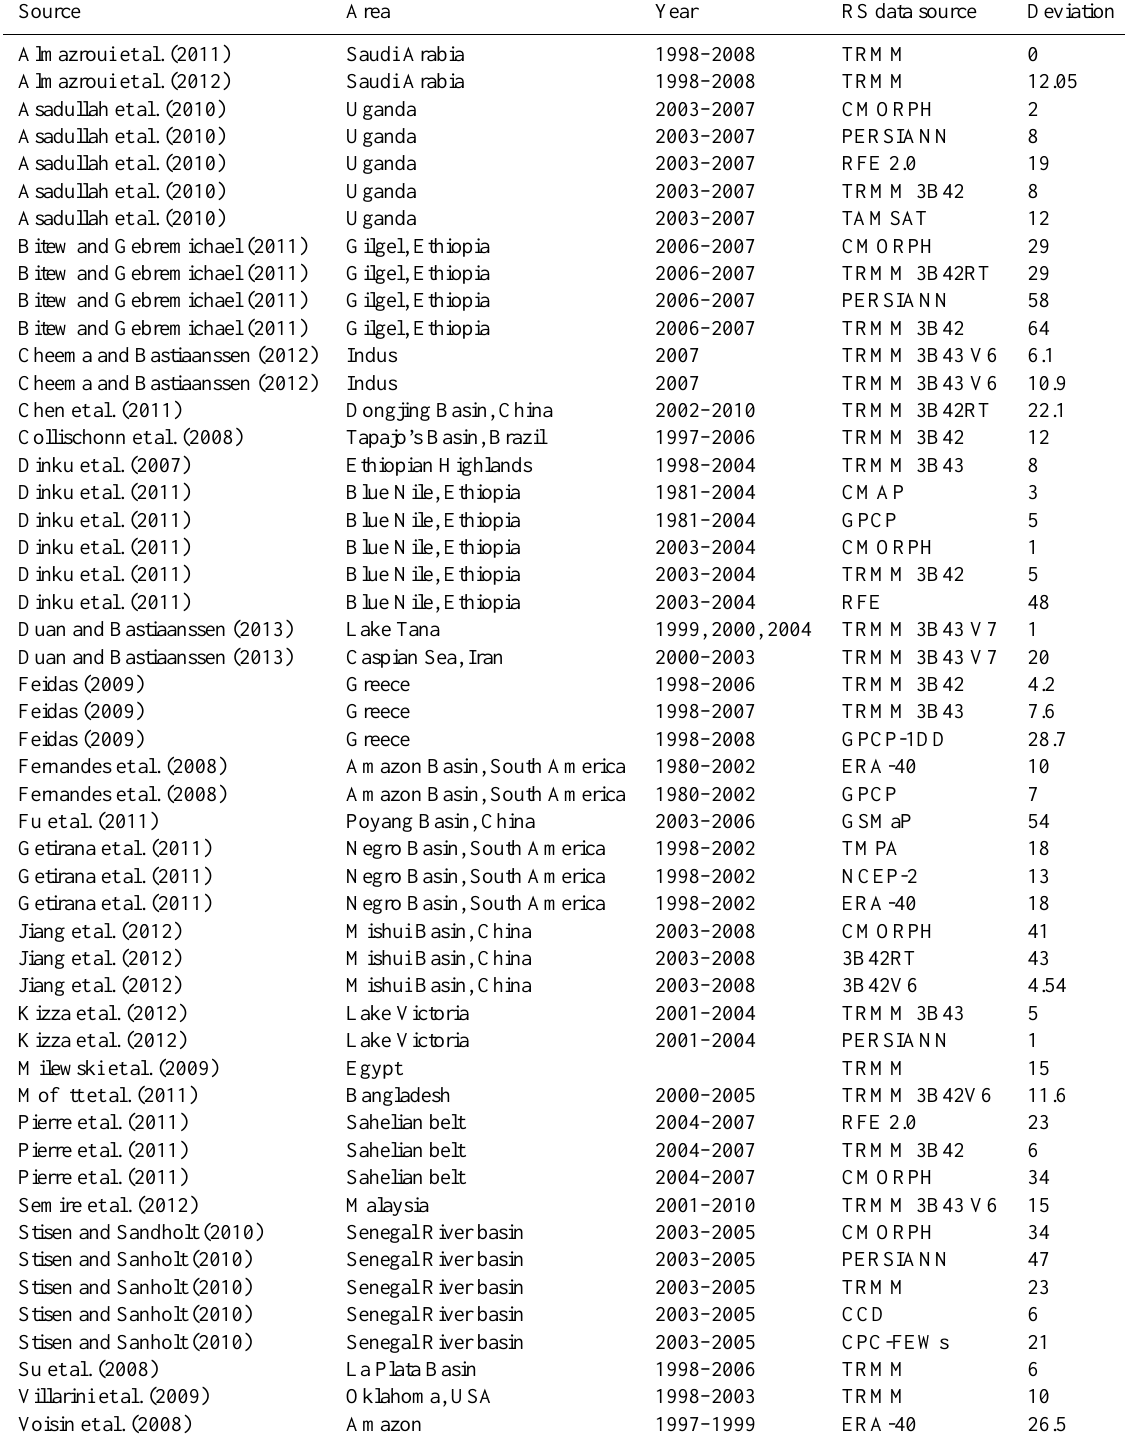
Table B1. Selected validation papers that describe experimental data sets covering a season or